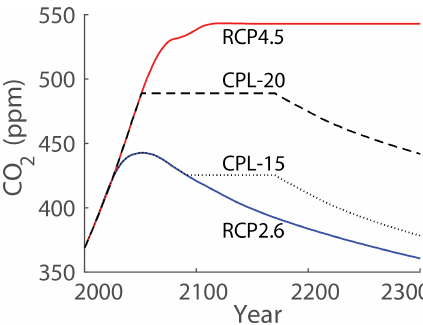
Figure 1. Time evolution of prescribed atmospheric CO 2 concen- tration for the 1.5 and 2.0 ◦ C warming experiments with NorESM1- Happi. The 1.5 ◦ C experiment (dotted black line) initially follows RCP2.6 (solid blue line). At year 2095, the concentration deviates from RCP2.6, staying constant until year 2170, and decreases there- after. The 2.0 ◦ C experiment (dashed black line) similarly follows RCP4.5 (solid red line) at first but branches off at year 2050. The concentration is then constant until the year 2170 before decreasing in the same fashion as in the 1.5 ◦ C experiment. Units are in ppm.